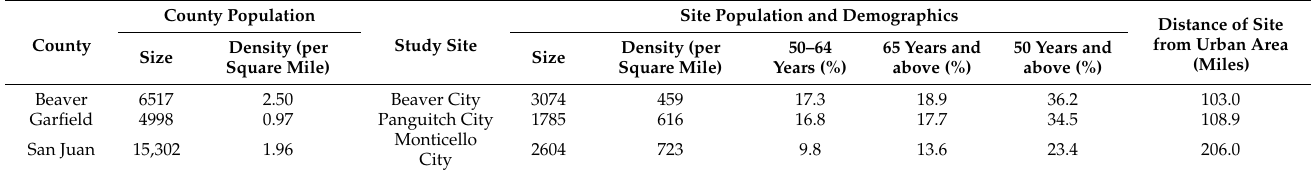
Table 1. Characteristics of the counties and cities of the three rural study locations, 2019. Population numbers are from the 2019 American Community Survey (ACS) data 5-year estimates [28] (https://www.census.gov/programs-surveys/acs/, accessed on 2 July 2021); area (square miles) for density calculation is from the US Census [29]; study site = the locale where the study intervention was conducted within the respective county, which is the county seat in all cases; distance from urban = distance from the study site to the nearest city with a population